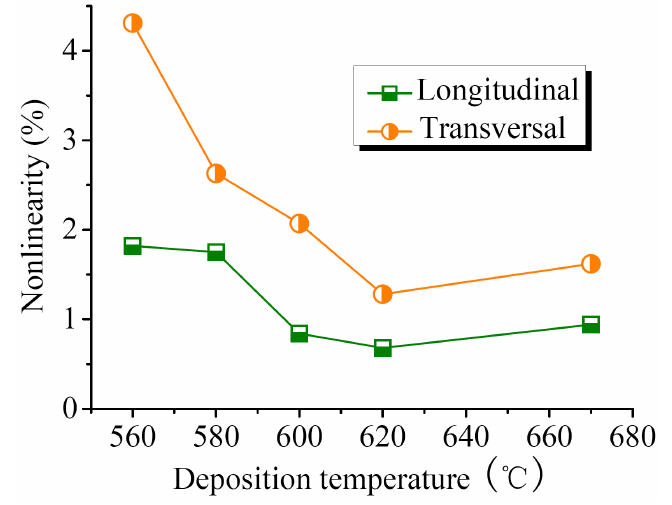
Figure 15. PRNL of longitudinal and transversal PSNF piezoresistors as a function of deposition